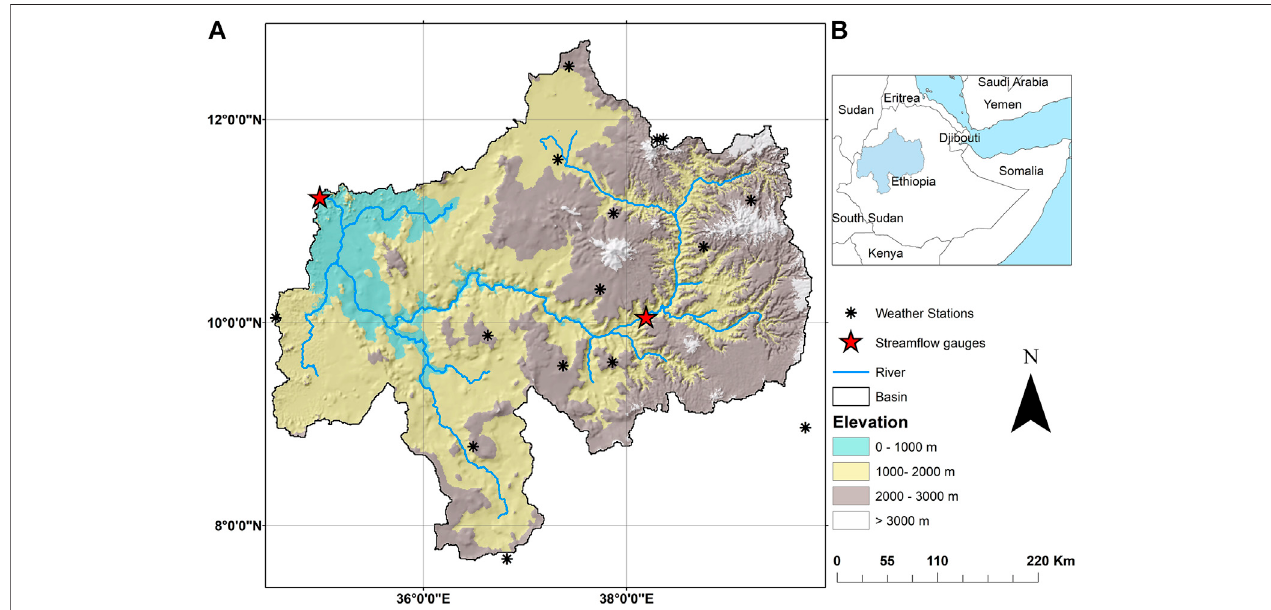
FIGURE1| Studyarea. (A) ThedigitalelevationmapoftheUpperBlueNileRiverBasin(UBNRB)andthelocationof15weatherstations. (B) Insetmapshowingthe relative location of the study area.